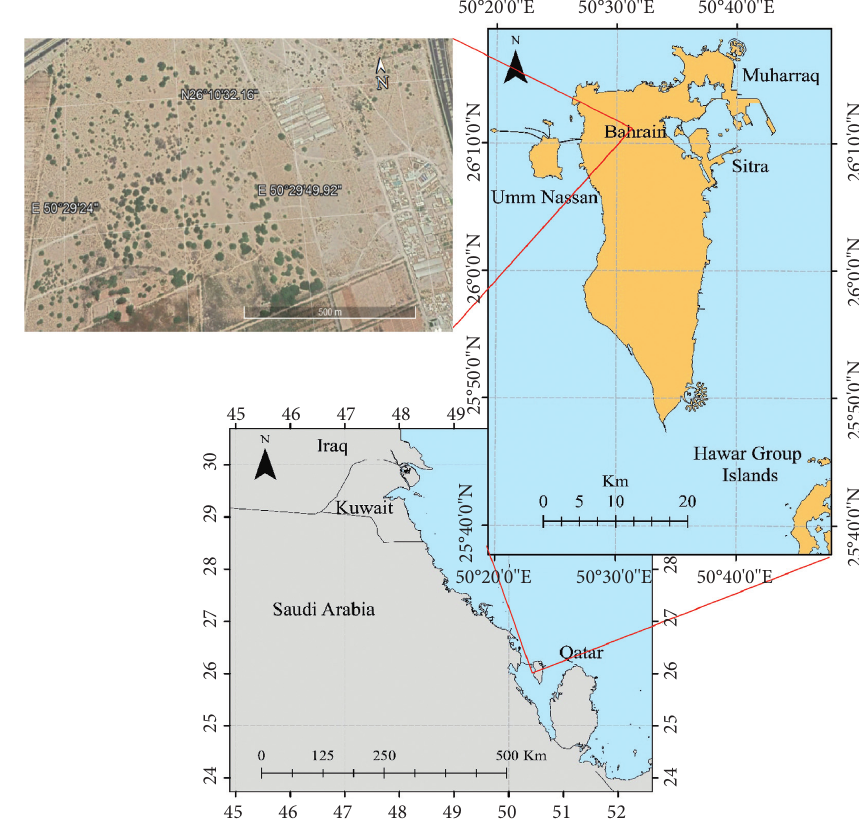
Figure 1: The location of the study area.